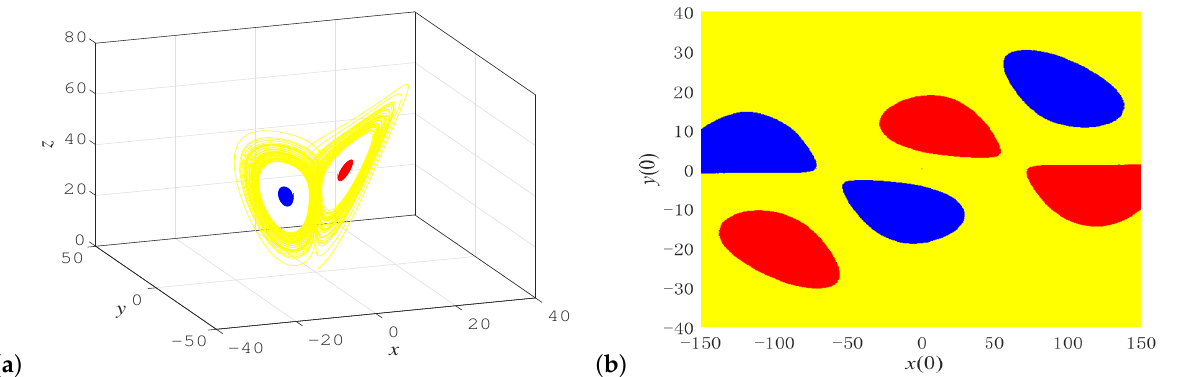
Figure 6. Coexisting hidden chaotic attractor and stable equilibrium state attractors of system (2); ( a , b , c , d ) = ( 35,3,35,10 ) : ( a ) 3D phase portraits; ( b ) basins of